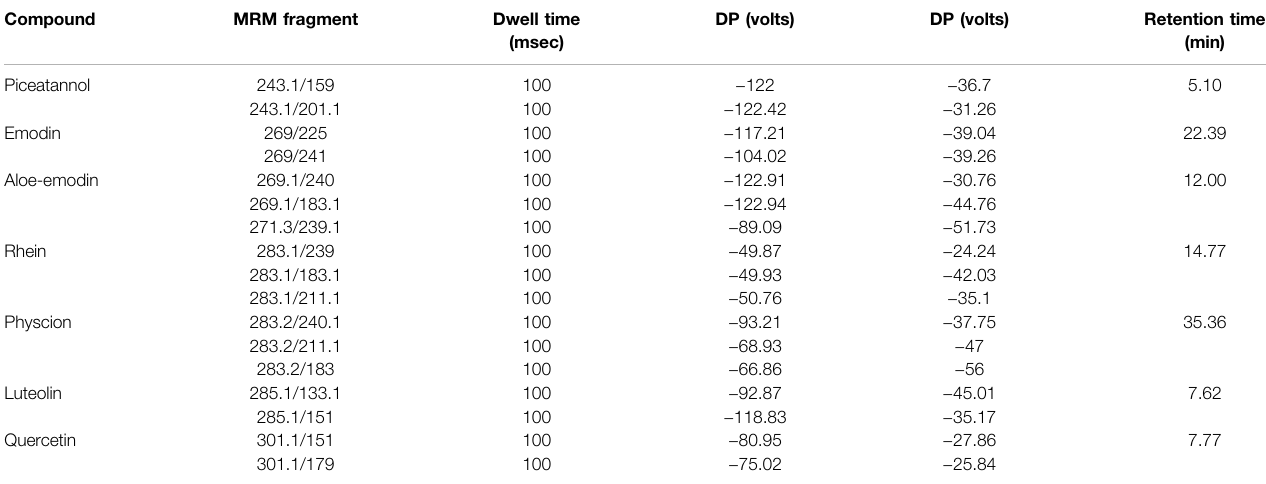
TABLE 1 | Ions and fragmentations used in the MRM mode for seven compounds.